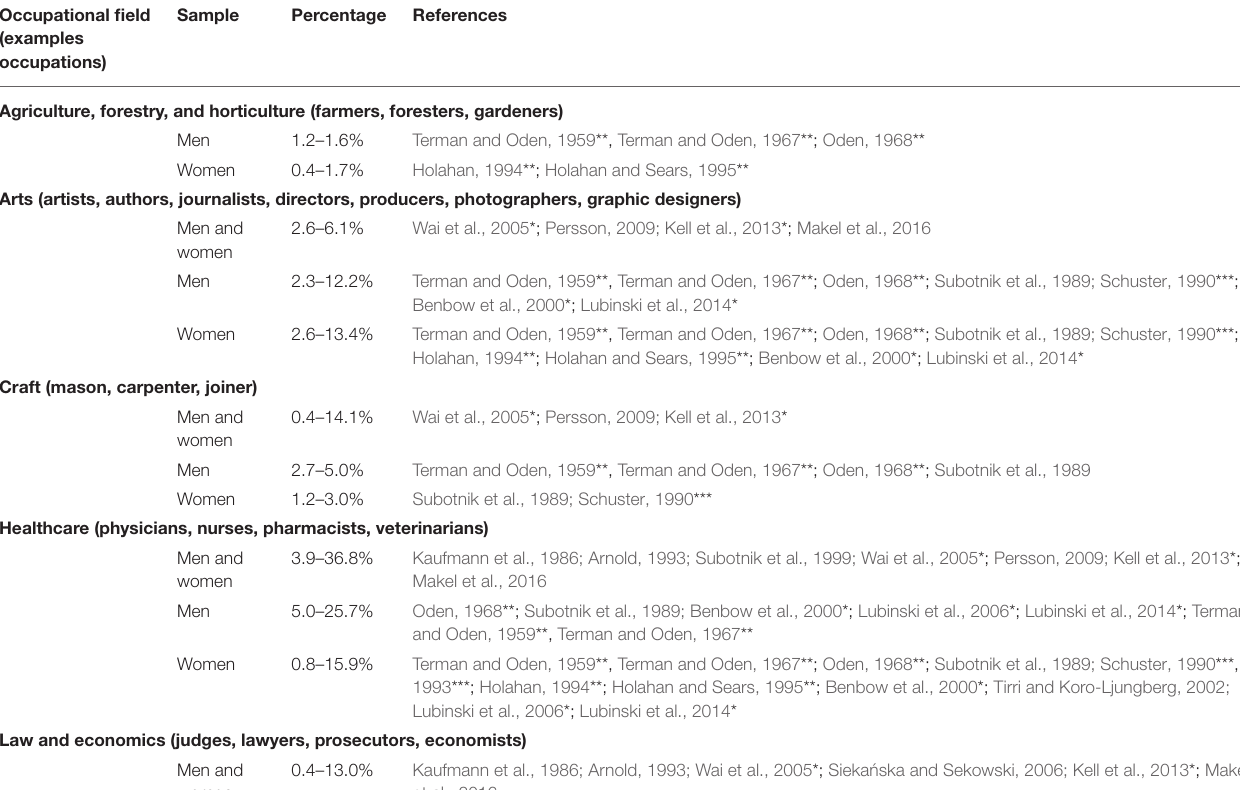
TABLE 3 | Occupational fields in which gifted men and women work. Occupational field